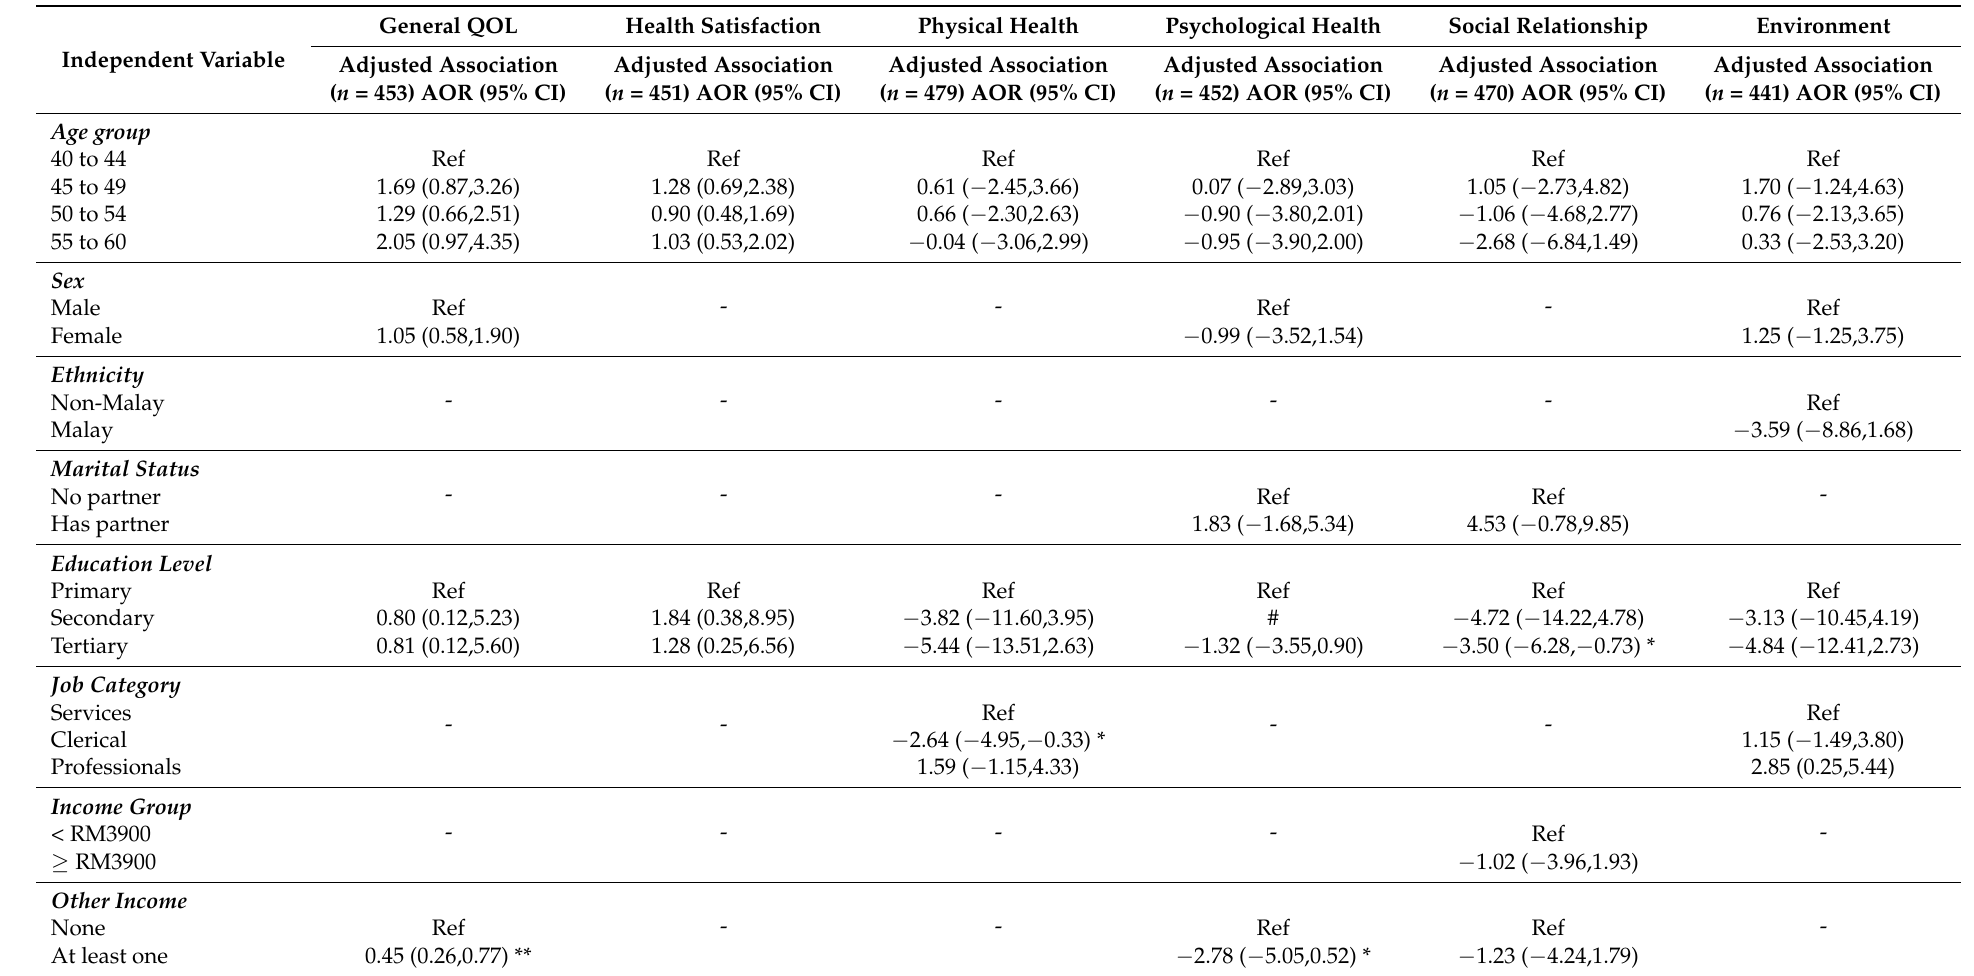
Table 3. Multiple Regression Analysis on the Relationship between QOL and